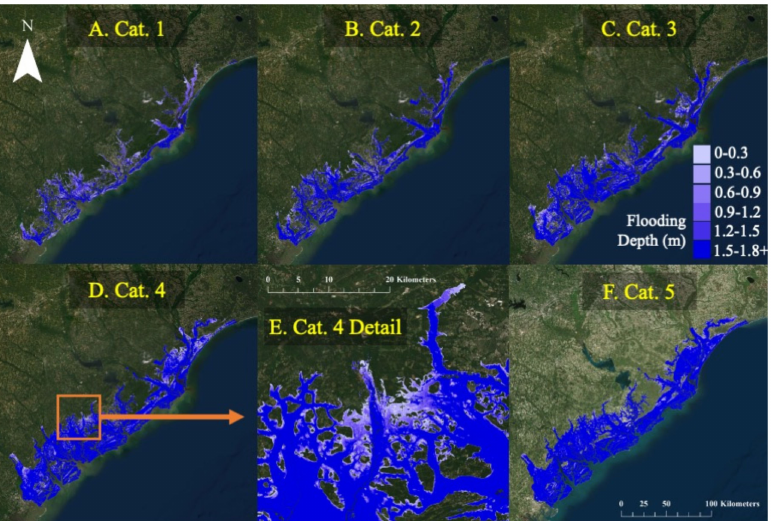
Figure 4. Hurricane-induced storm surge inundation maps of the coastal counties of South Carolina based on hurricane intensity: Category 1 ( A ); Category 2 ( B ); Category 3 ( C ); Category 4 ( D ); Category 5 ( F ). Map ( E ) shows a “blow up” of parts of Dorchester and Colleton counties illustrating the storm surge for a Category 4 storm with greater differentiation visible between the flooding depth categories. Service Layer Credits: Source: Esri, Maxar, GeoEye, Earthstar Geographics, CNES/Airbus DS, USDA, USGS, AeroGRID, IGN, and the GIS User